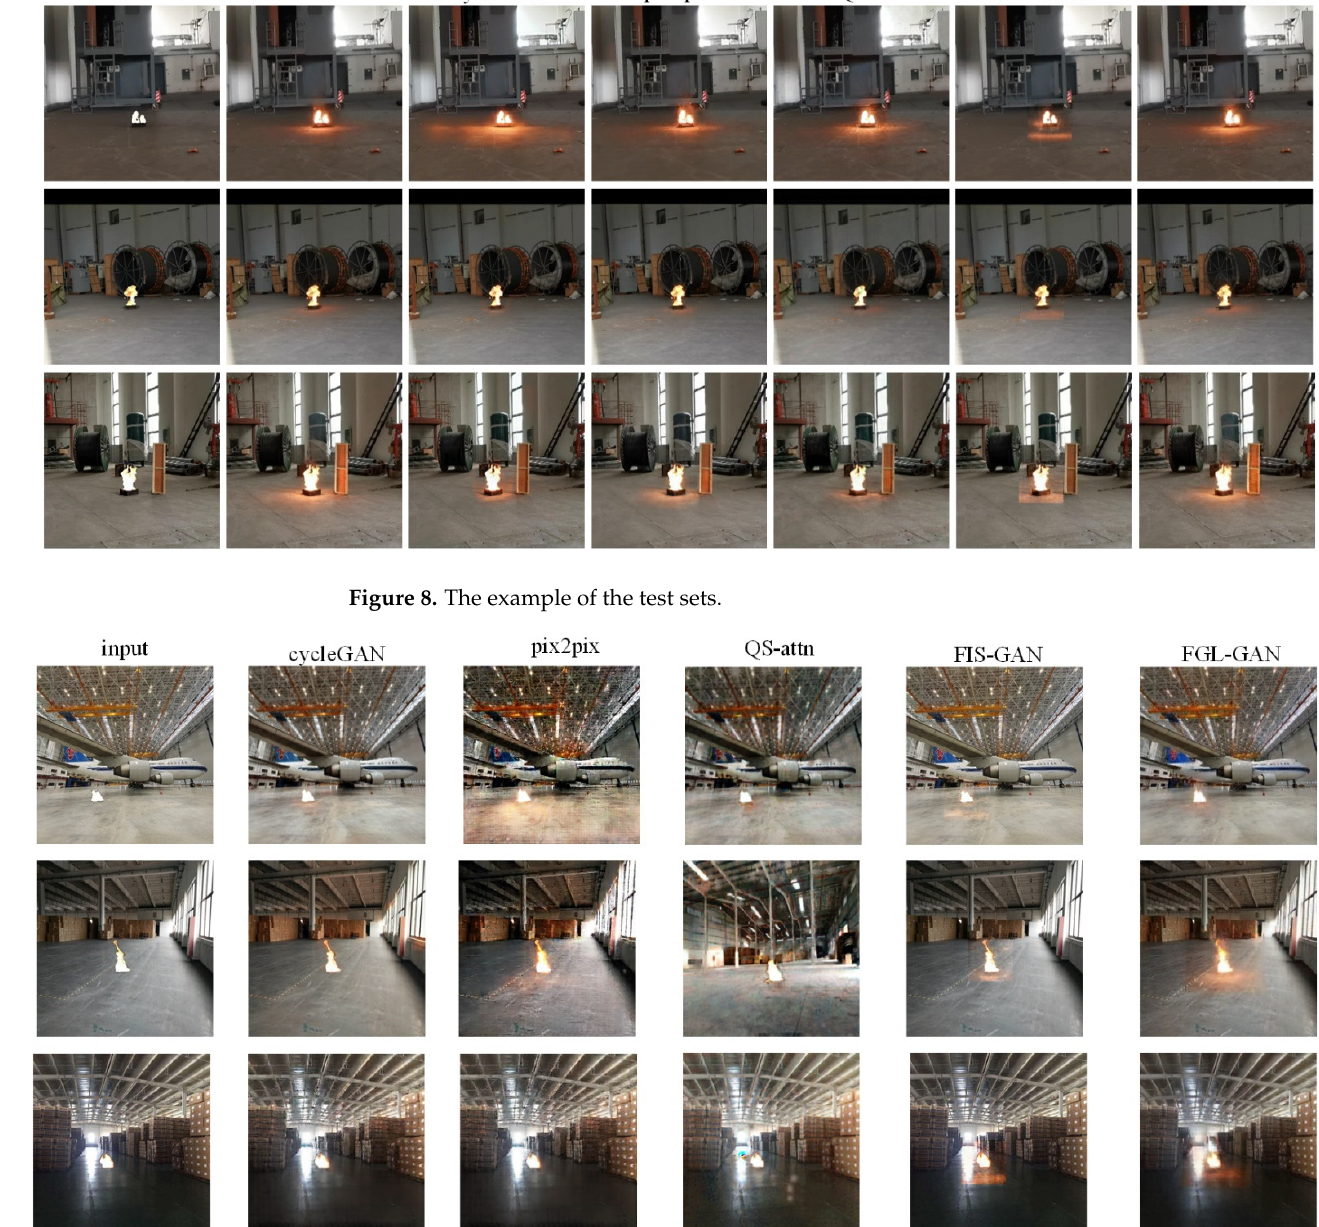
Figure 9. An example of the prediction sets.